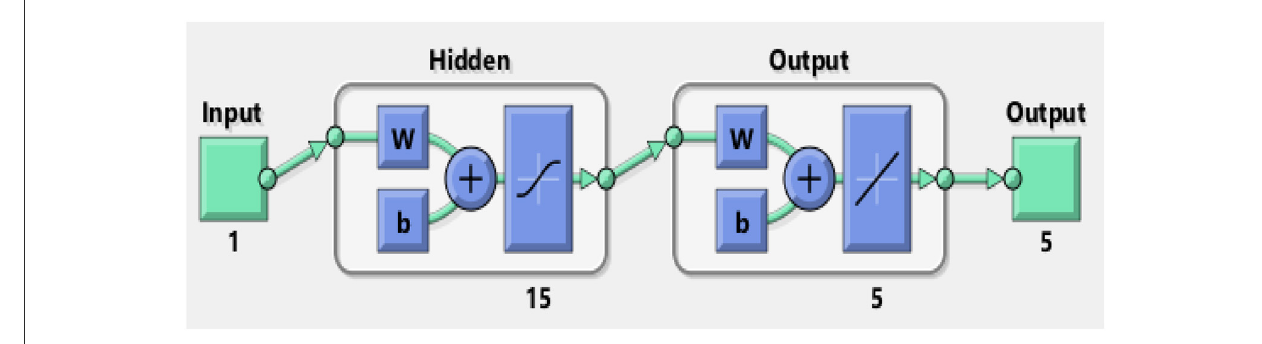
FIGURE1 Designed ANN-LBVMBP method for HBVNS.